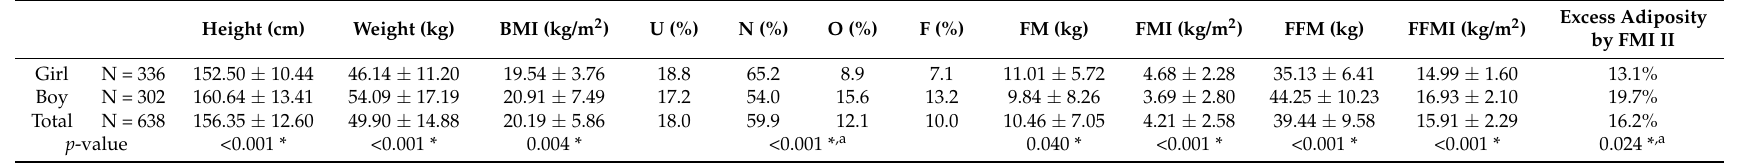
Table 1. Baseline characteristics of all subjects aged from 10 to 18 years old.